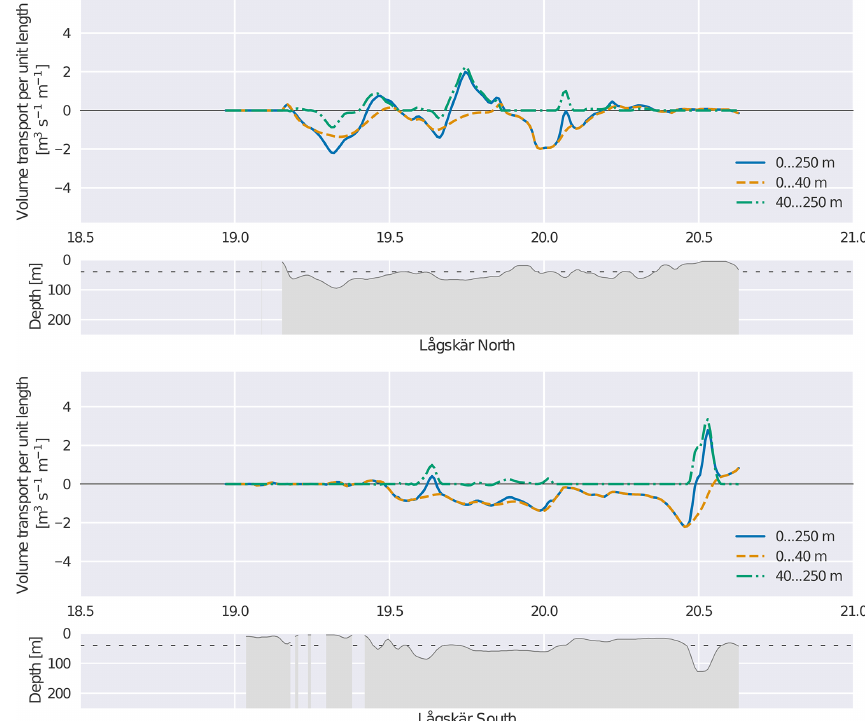
Figure 13. The same as Fig. 11 but for the two southernmost transects (LN and LS).